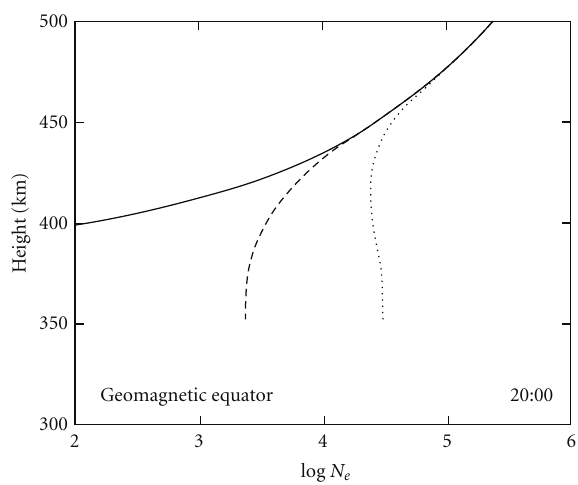
Figure 8: The height distribution of log N e at 20:00 LT on the equator. The full, dashed, and dotted lines represent the cases in which the nocturnal ionization productions are 0%, 0.2%, and 2% of noon production respectively (from Huang